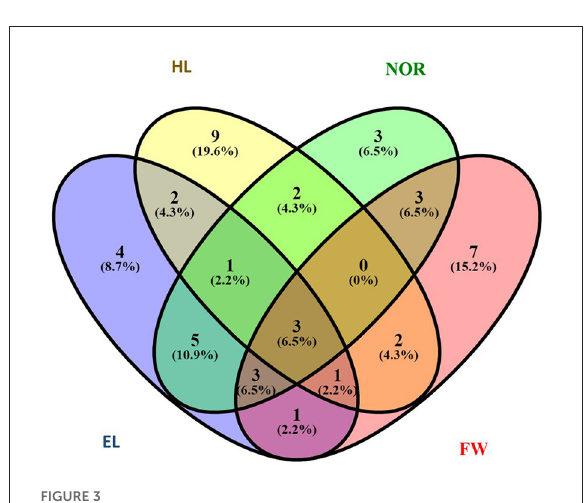
FIGURE3 Number of genotypes with high